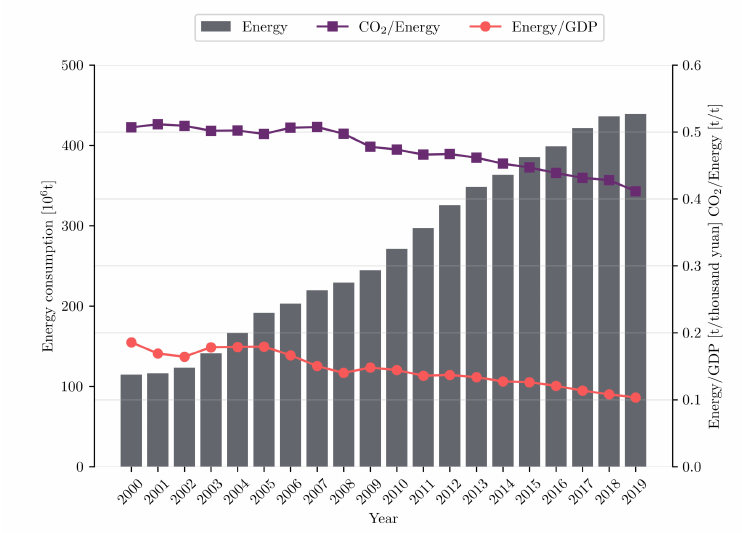
Figure 3. Energy consumption, energy intensity, and carbon intensity of energy consumption in the logistics industry in